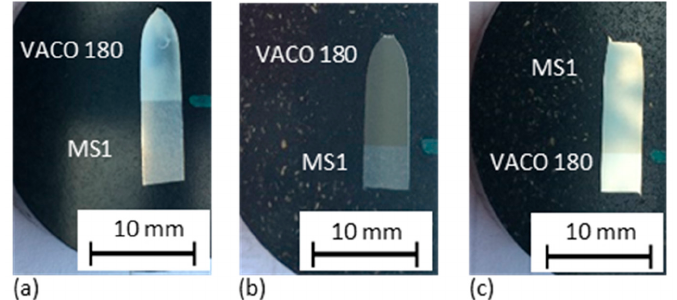
Figure 15. Metallographic longitudinal sections through fractured bars (the fracture area is at the top), showing the distance of the fracture from the MS1/VACO 180 interface for hybrid parts: ( a ) without heat treatment; ( b ) in the solution annealed condition; and ( c ) precipitation annealed con ‐ ditions.